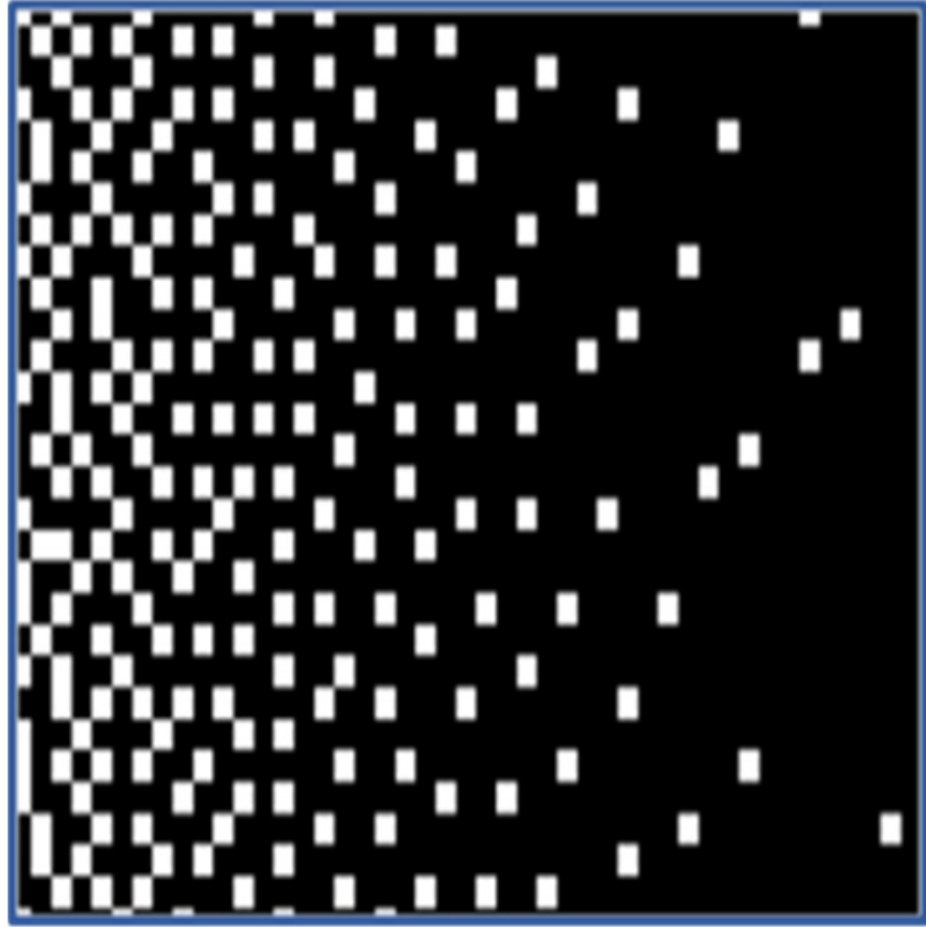
Figure 4. The design layout of grayscale coding mask (enlarged view).